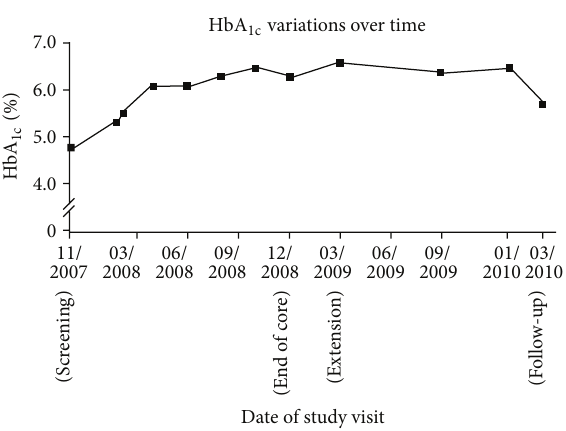
variations over 1c